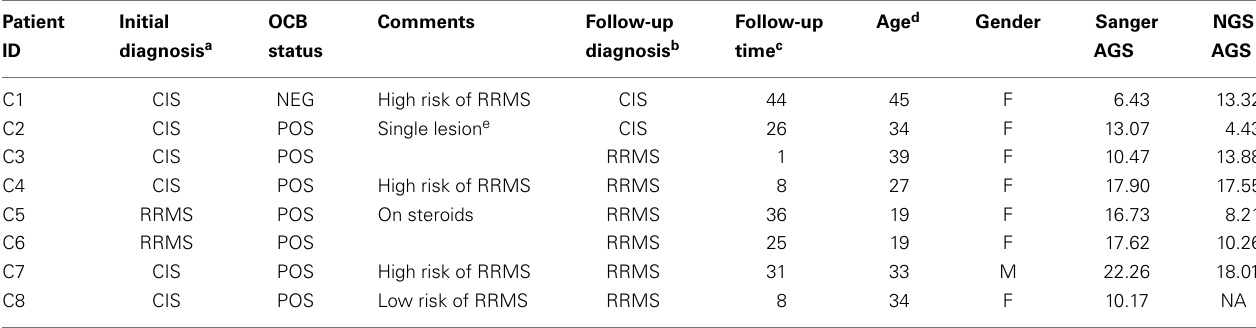
Table 1 | Patient sample summary .